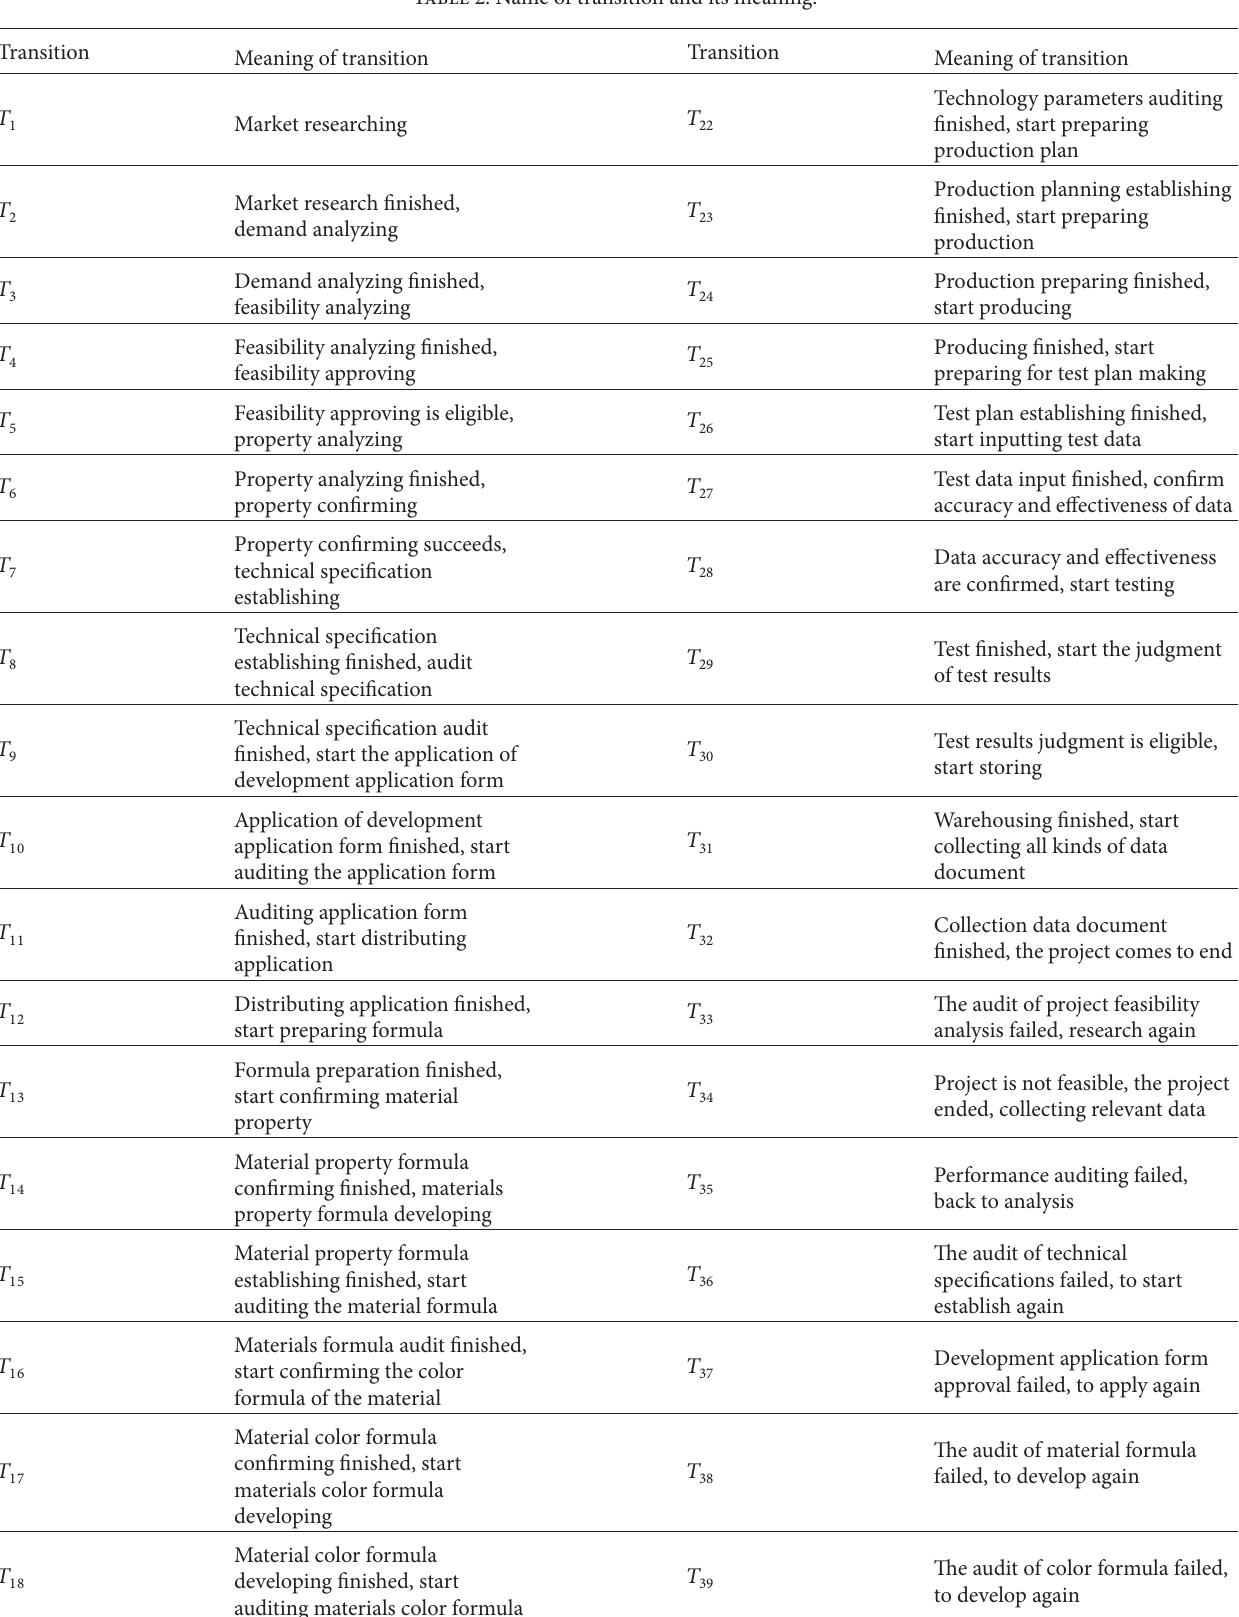
Table 2: Name of transition and its